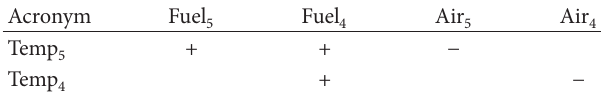
Table 9: Reduced mapping matrix.